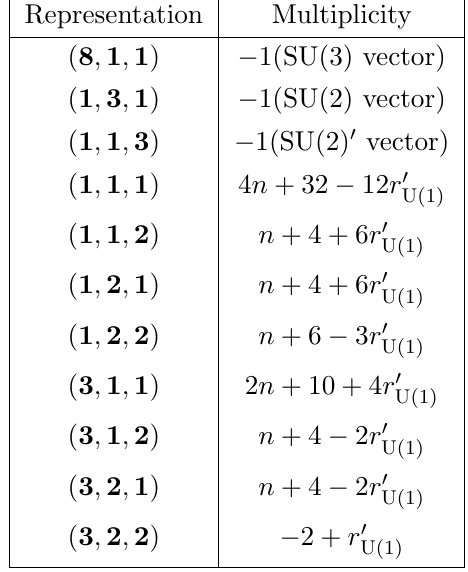
Table 15 . The spectrum for the con(cid:12)guration No.12. H = SU(4) (cid:2) U(1).